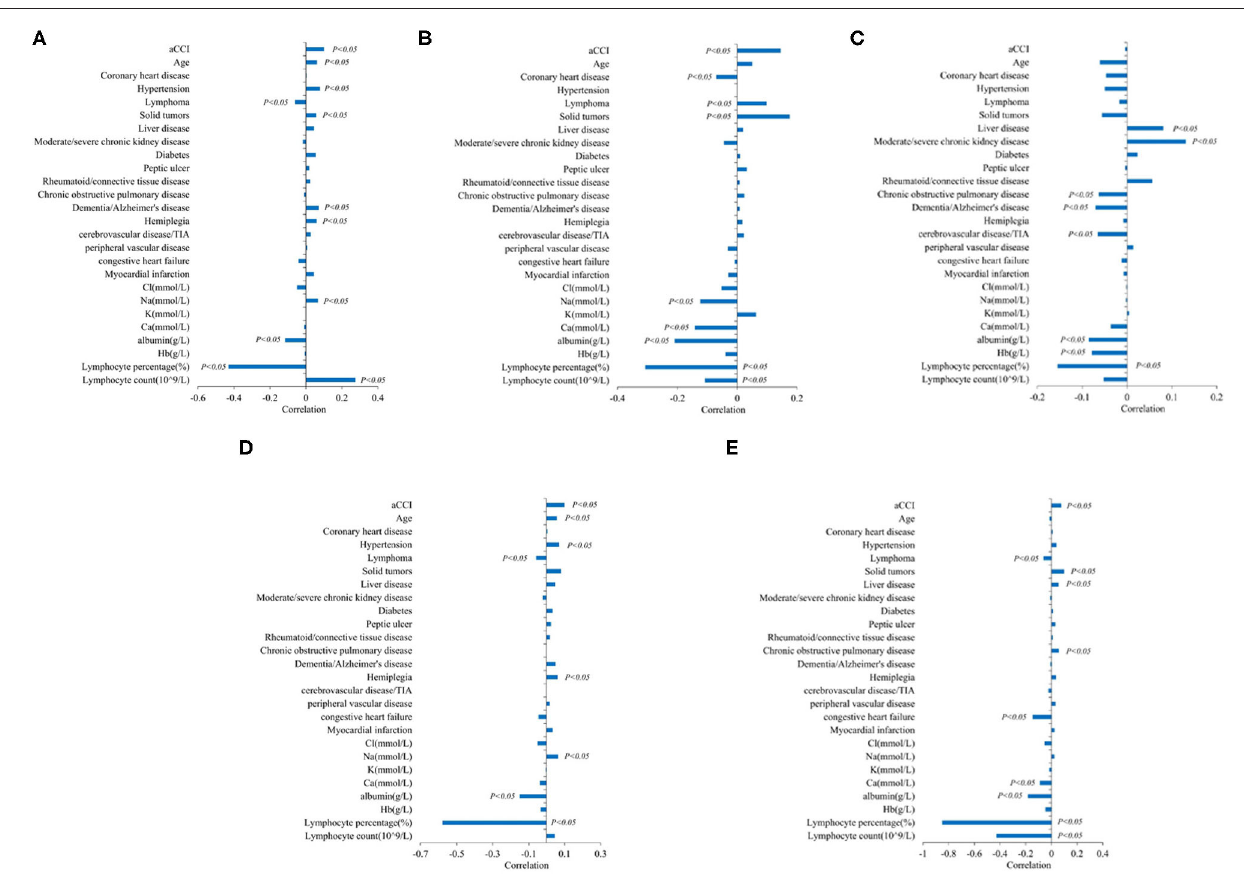
FIGURE 3 | Correlation analysis of aging-related risk factors and infection. (A) Correlation analysis of aging-related risk factors and white blood cell level. (B) Correlation analysis of aging-related risk factors and CRP. (C) Correlation analysis of aging-related risk factors and PCT. (D) Correlation analysis of aging-related risk factors and neutrophils count(10 ∧ 9/L). (E) Correlation analysis of aging-related risk factors and neutrophils percentage (%). pneumonia each year, and about 4 million people die from it